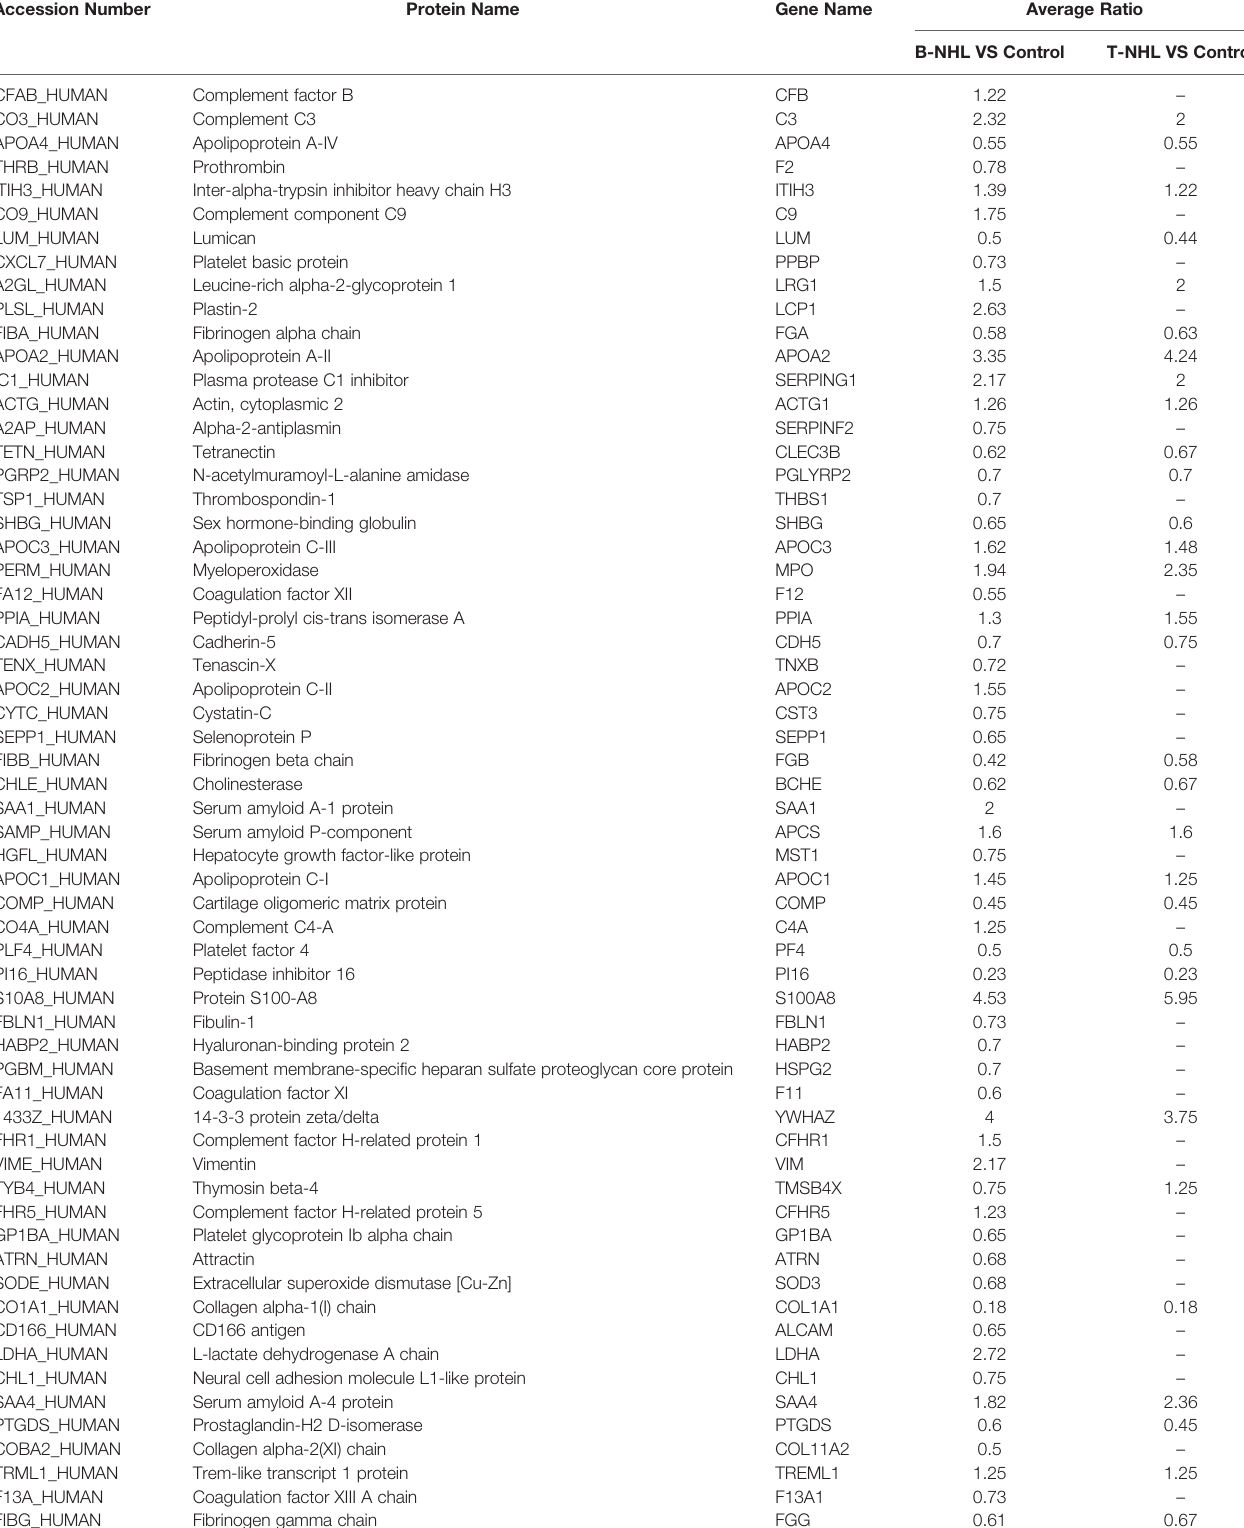
TABLE 2 | Differentially expressed proteins identi fi ed in B-NHL and T-NHL compared with the control by iTRAQ-based proteomic